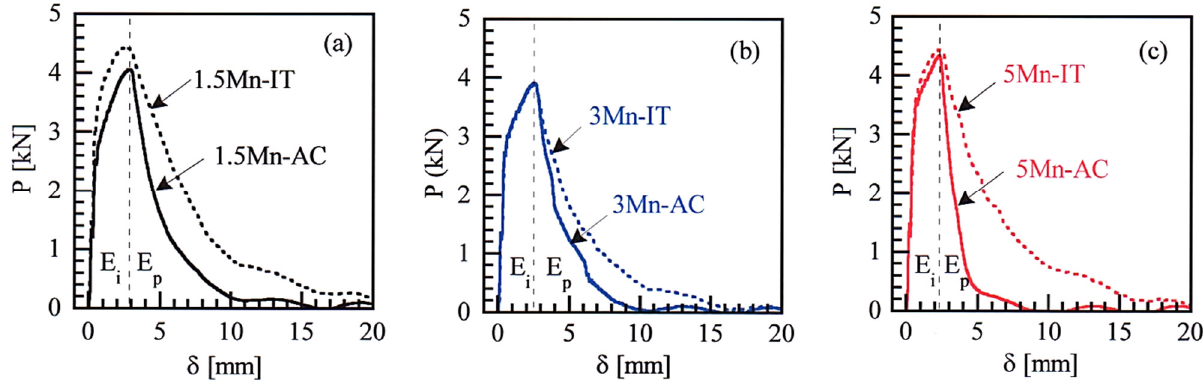
Figure 9. Impact load-displacement ( P - δ ) curves at T t = 25 °C of ( a ) the 1.5 Mn, ( b ) 3 Mn, and ( c ) 5 Mn steels subjected to the AC (thick lines) and IT (thin lines) processes. E i and E p are crack-initiation and propagation energies, respectively, where E i + E p = E v .